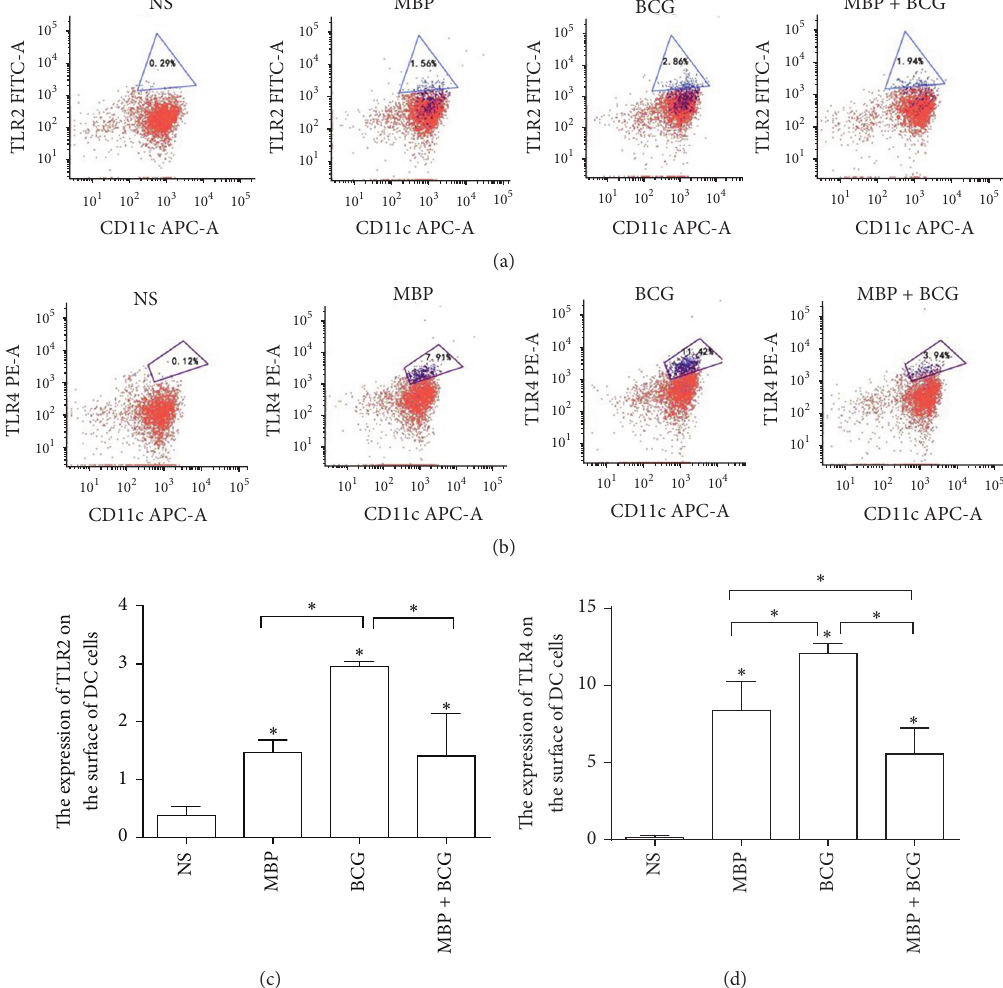
Figure 7: The effect of the combination of MBP and BCG on the expression of the surface molecules TLR2 and TLR4 on DCs in vivo. DCs isolated from the spleens of normal mice immunized with MBP, BCG, or the combination of MBP and BCG were incubated with FITC-conjugated anti-TLR4, PE-conjugated anti-TLR2, and APC-conjugated anti-CD11c at 4 ∘ C for 30 min. Then, cells were analyzed for the expression of TLR2/TLR4 on DCs with flow cytometry. (a) TLR4 expression on DCs from mice immunized with MBP, BCG, or the combination of MBP and BCG. (b) The expression of TLR2 on DCs isolated from the spleens of mice immunized with MBP, BCG, or the combinationofMBPandBCG.(c-d)ThepercentageofCD11c + cellsexpressingtheTLR2/TLR4moleculesisexpressedasthemean ± standard deviation and is shown in a bar graph. Data are derived from three independent experiments. ∗ 𝑃 < 0.05 is considered to indicate statistically significant differences compared with the NS